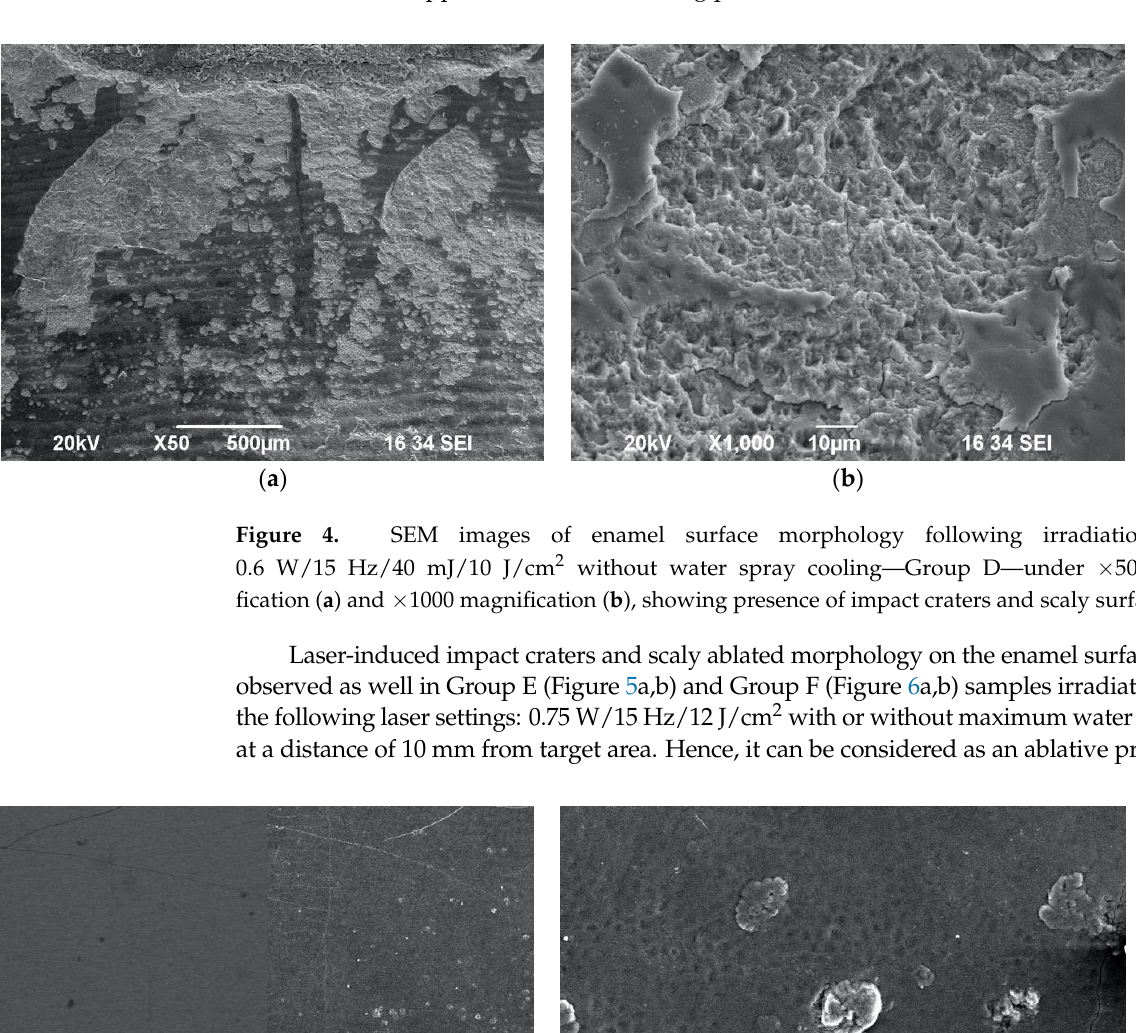
Figure 3. SEM images of tooth surface irradiated with 0.6 W/15 Hz/40 mJ/10 J/cm 2 with 100% water spray—Group C—under ×500 magnification ( a ) and ×1000 magnification ( b ). Observation of intact enamel surface morphology, showing striae of Retzius.